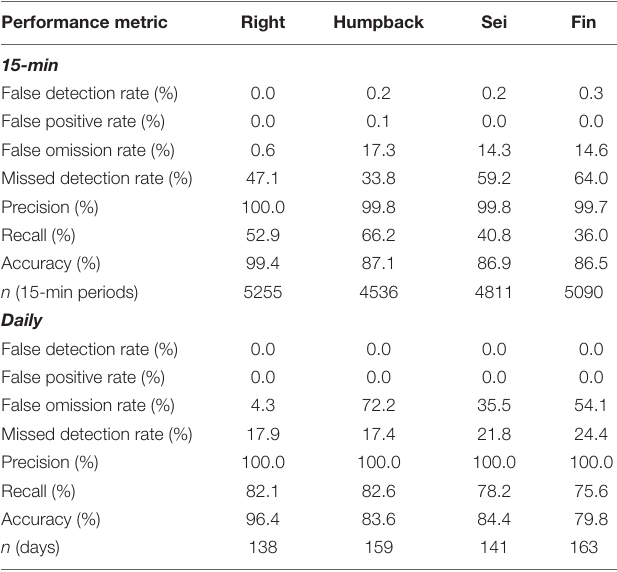
TABLE 2 | Performance metrics for the near real-time analysis (when treating the audio analysis as the “truth”) over 15-min and daily time scales for right, humpback, sei, and fin whales based on the confusion matrices in Table 1 .